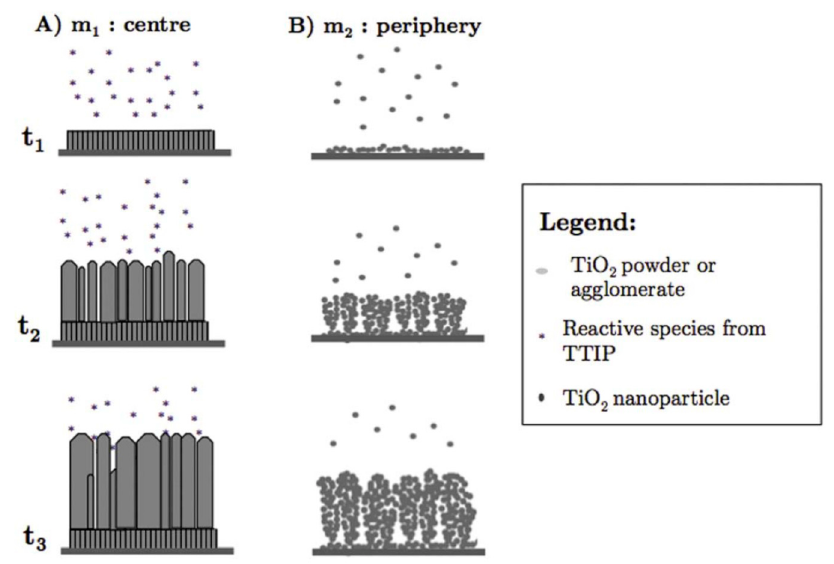
Figure 6. Different growth mechanisms of TiO 2 films in the ( A ) central and ( B ) peripheral zones during PECVD using a microwave plasma torch. Reprinted with permission from Ref. [51]. Copyright (2016) American Chemical Society.